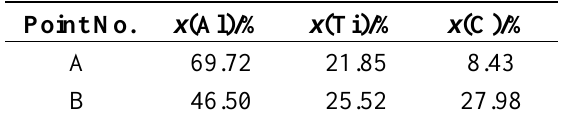
Table 1. EDS composition analysis of point A and point B in Figure